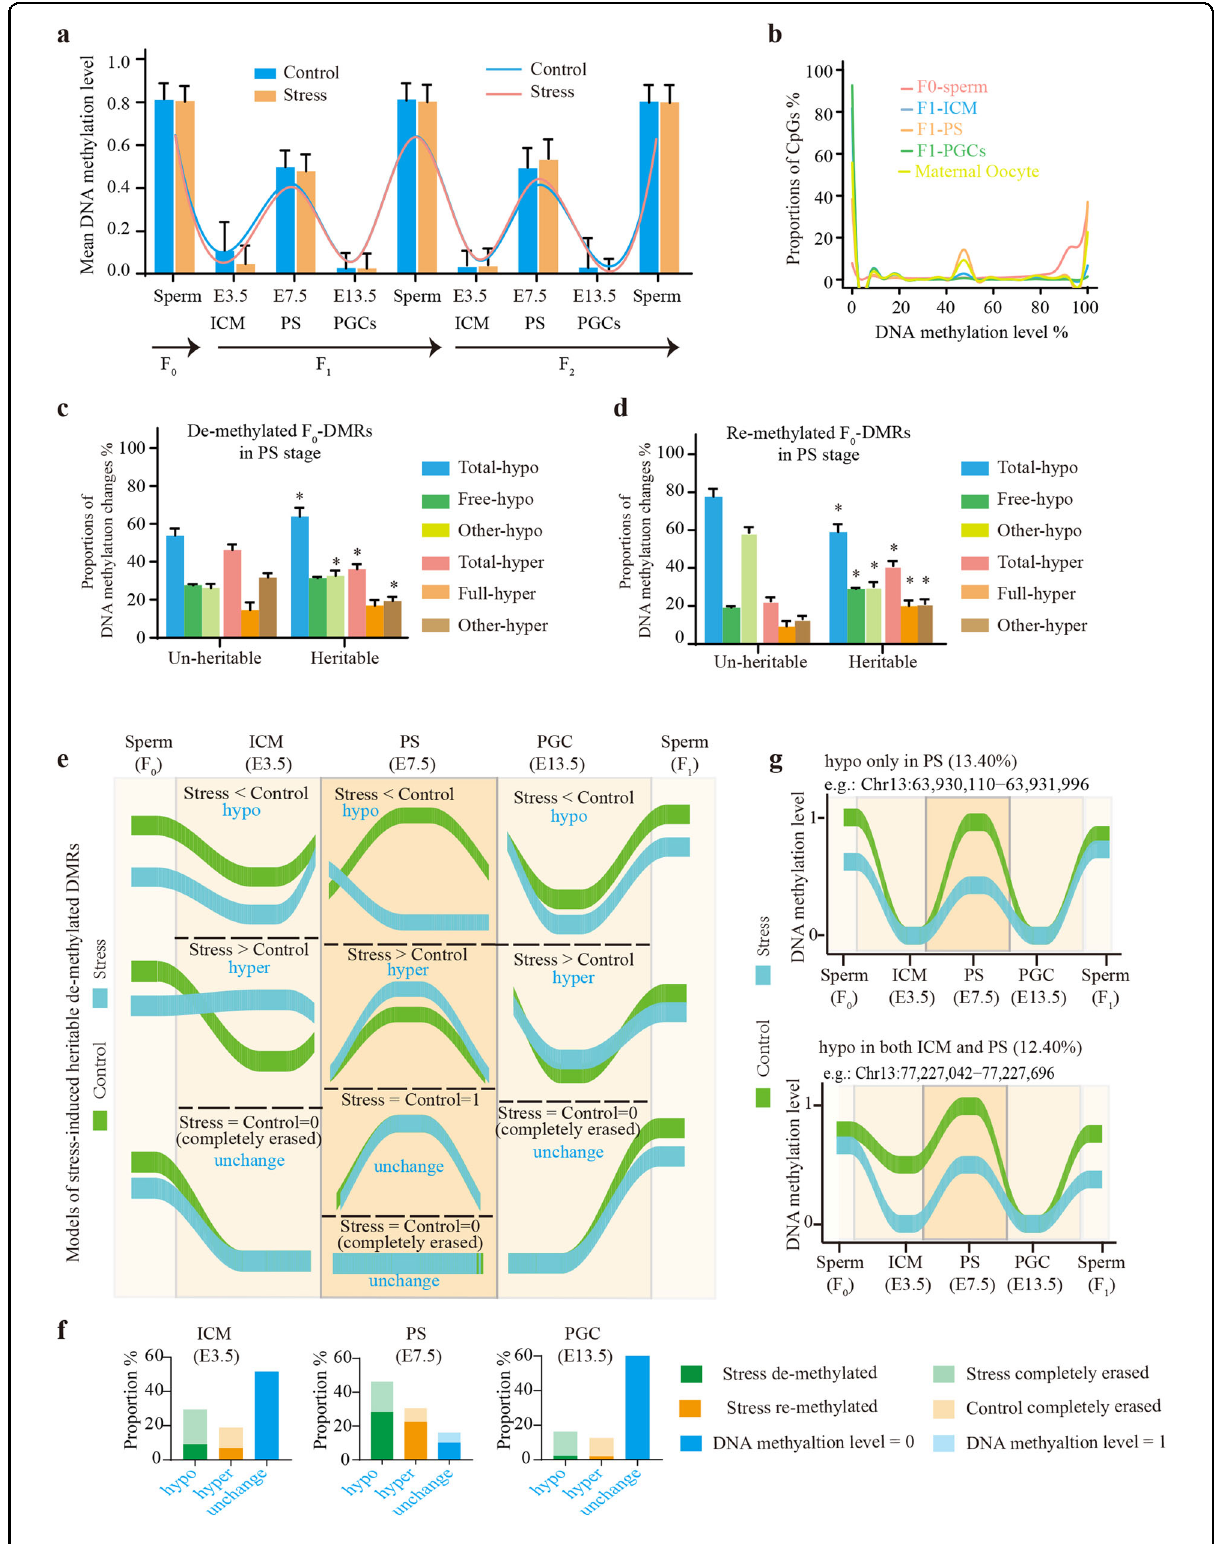
Fig. 5 (See legend on next